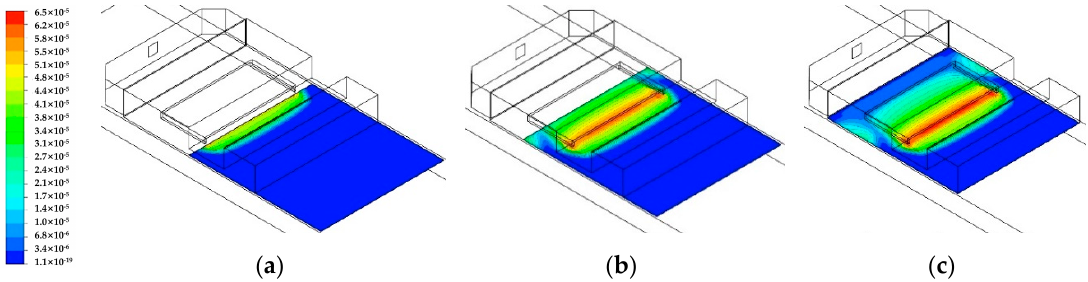
Figure 9. Comparisons of the contour of CdTe deposition rate (kg/m 2 ·s) on the substrate with the change over time: ( a ) t = 200 s; ( b ) t = 300 s; ( c ) t = 400 s.